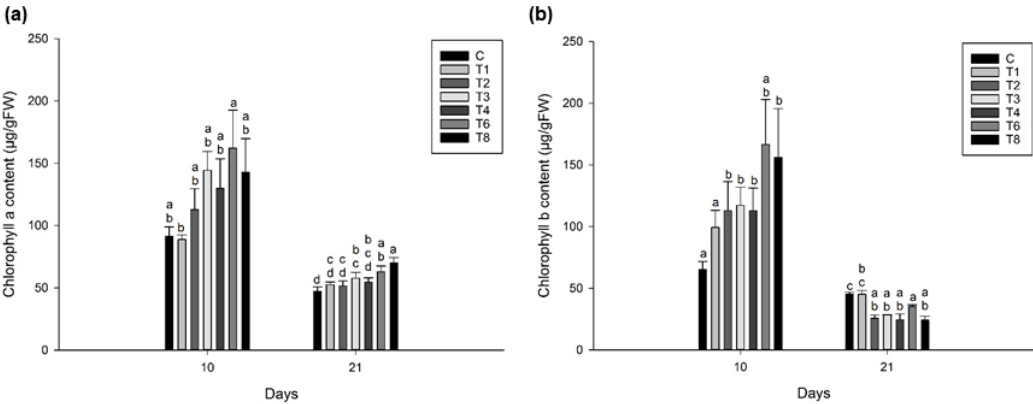
Figure 4. Effect of pretreatment of ANE and HA on the chlorophyll content of leaves of lettuce stored after harvest. The effect of different concentrations of ANE, HA, and ANE + HA on the ( a ) chlorophyll a and ( b ) chlorophyll b content of leaves of lettuce stored for 10 and 21 days at 0–4 °C in the dark with RH ≥ 95%. Different combinations of ANE and HA used for preharvest treatment were as follows: C (control), T1 (0.1% ANE), T2 (0.25% ANE), T3 (0.2% HA), T4 (0.4% HA), T6 (0.1% ANE + 0.4% HA), andT8 (0.25% ANE + 0.2% HA). Each experiment was performed in triplicate, and each experimental unit had six plants. The average of the eighteen values were presented as mean ± SE and means represented by same letters were not significantly different at p ≤ 0.05.